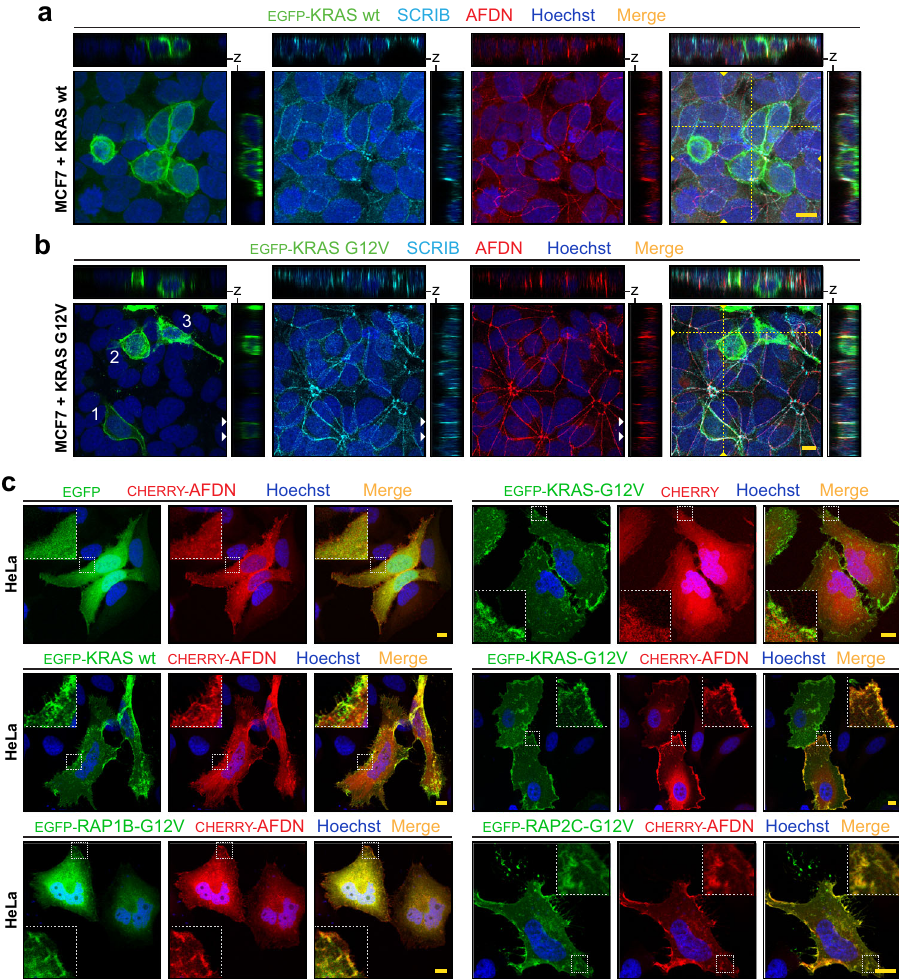
Fig. 5 | RAS GTPases co-localize with AFDN. a Expression of wild-typeKRASdoes not alter AFDN or SCRIB localization. EGFP-KRASwasexpressedinMCF7 cells, and localization of endogenous AFDNand SCRIB wasdetectedby immunostaining and confocal microscopy. Projections of z -stacks are at right and top. Position of associated z projections are shown with dashed yellow lines in the merged image. Scale bars represent 10 µ m. b KRAS-G12V co-localizes with AFDN and SCRIB in MCF7 cells. Following expression of EGFP-KRAS-G12V, endogenous AFDN and SCRIB were detected by immunostaining. Cells expressing KRAS are found in the